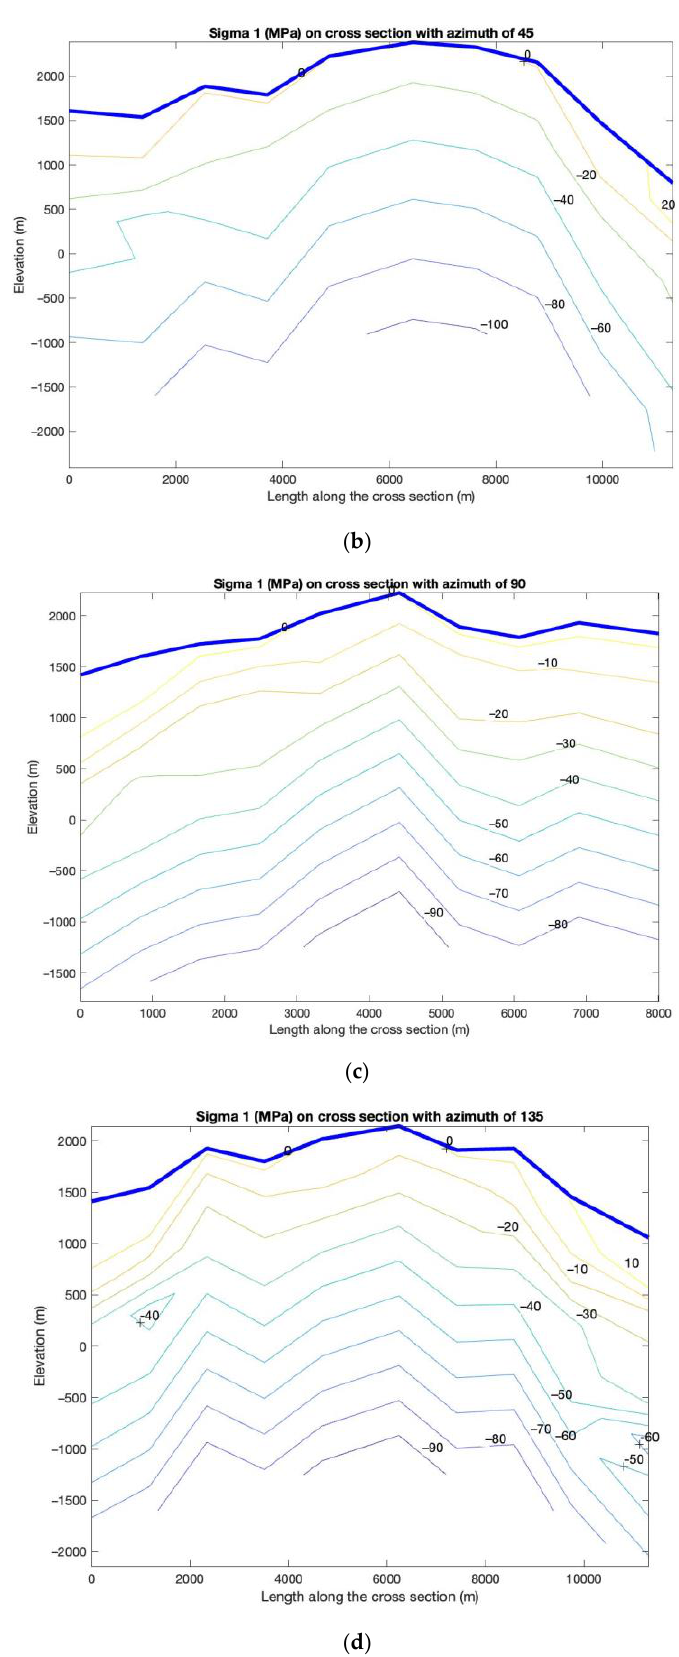
Figure 11. S1 magnitude contour with tectonic stresses in cross-section view with varying azimuth. ( a ) E-W; ( b ) NW-SW; ( c ) N-S; ( d ) NW-SE.